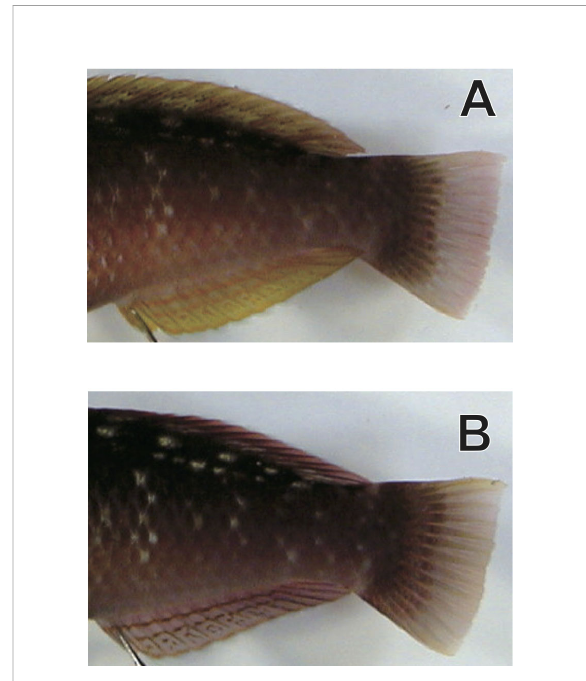
FIGURE 5 Changes in the anal fi n coloration in the semi-gonadectomized P. sieboldi . Images from (A) the beginning and (B) the end of the experiment are presented. Sex changes were induced in fi sh after semi-gonadectomy and placed in a 500 L tank during the pre-spawning